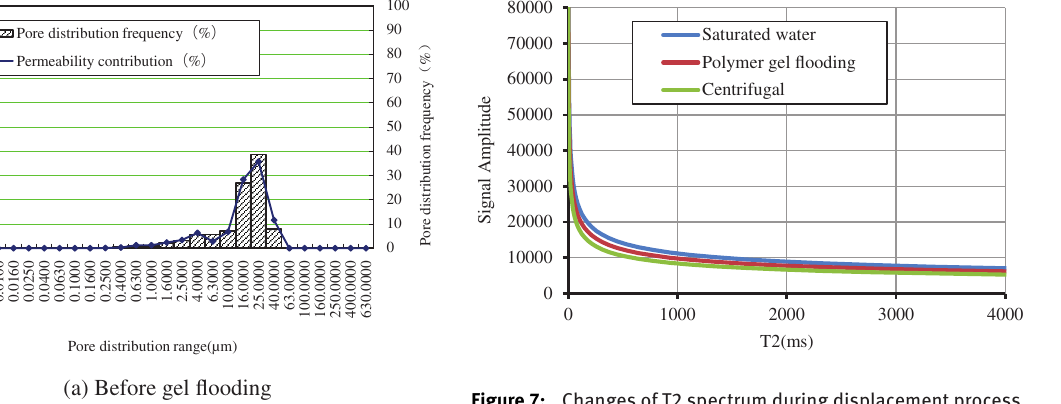
Figure 7: Changes of T2 spectrum during displacement process.